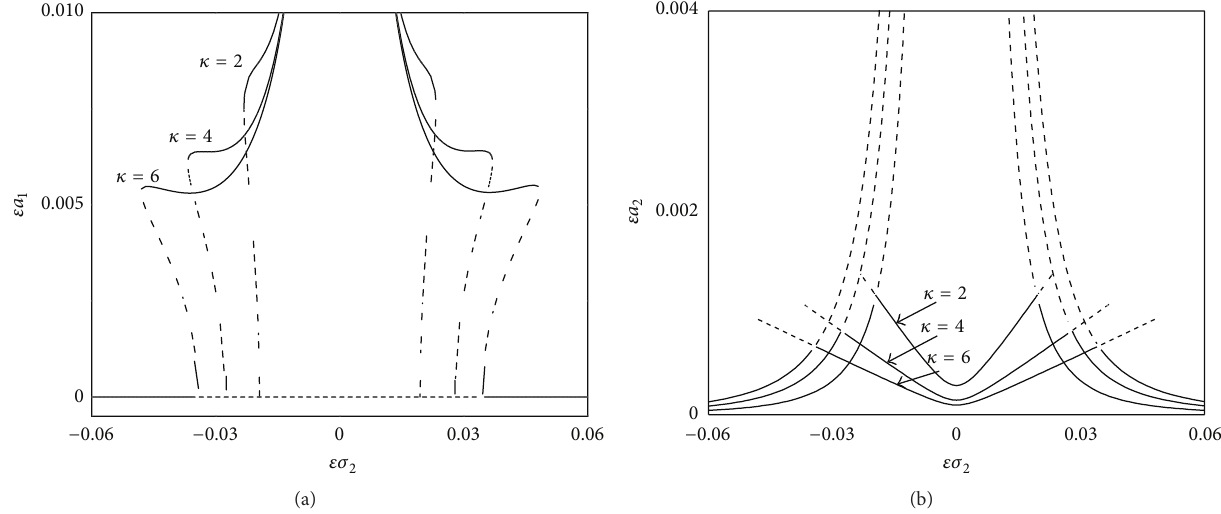
Figure 8: Amplitude-frequency curves of the second superharmonic resonance for different nonlinearity coefficients: (a) the first mode and (b) the second mode.